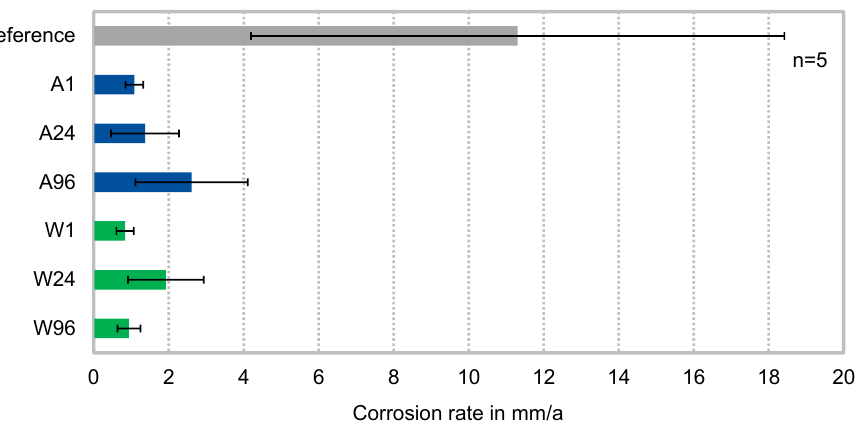
Figure 5. Corrosion rates of the platelets (in mm/a) during potentiodynamic polarisation as a function of heat treatment and cooling conditions.